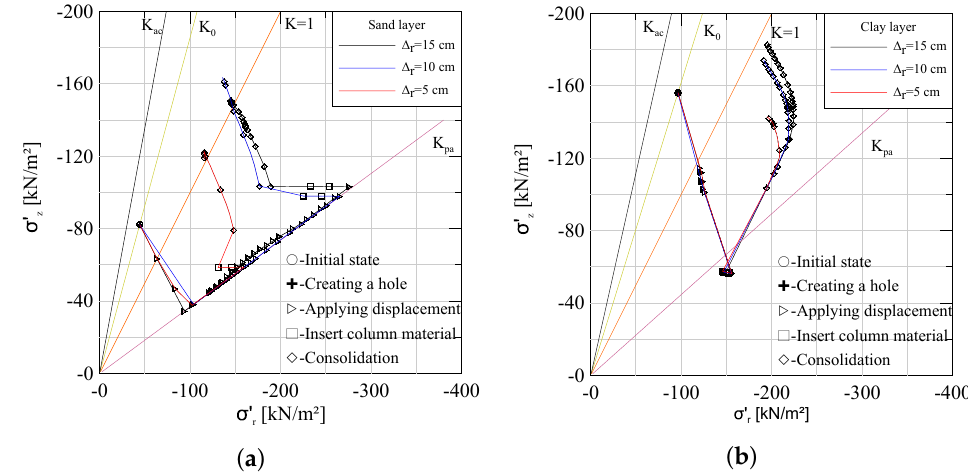
Figure 9. Stress paths for different cavity expansion in two layers at a distance of 0.4 from column axis. ( a ) sand layer; ( b ) clay